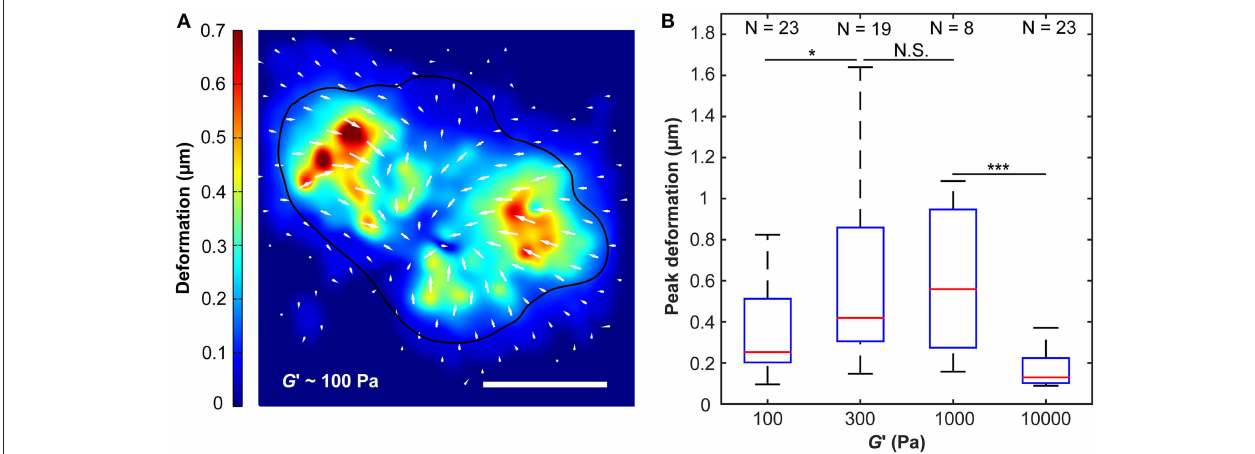
FIGURE 3 | Substrate deformations as a function of substrate stiffness. (A) Substrate deformation field of one representative cell grown on a ∼ 100 Pa substrate (cell outline in black). Deformation directions are indicated by white arrows, absolute deformations are shown by false colors. Scale bar: 10 µ m. (B) Peak deformations reached a maximum on substrates of around G ′ ∼ 300–1000 Pa. N, number of analyzed cells. * p < 0 . 05 ; *** p < 0 . 001 .